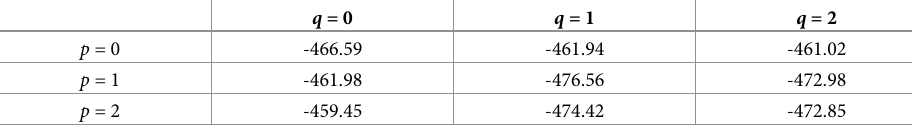
Table 3. BIC test for monthly incidence of hepatitis E by p , q .